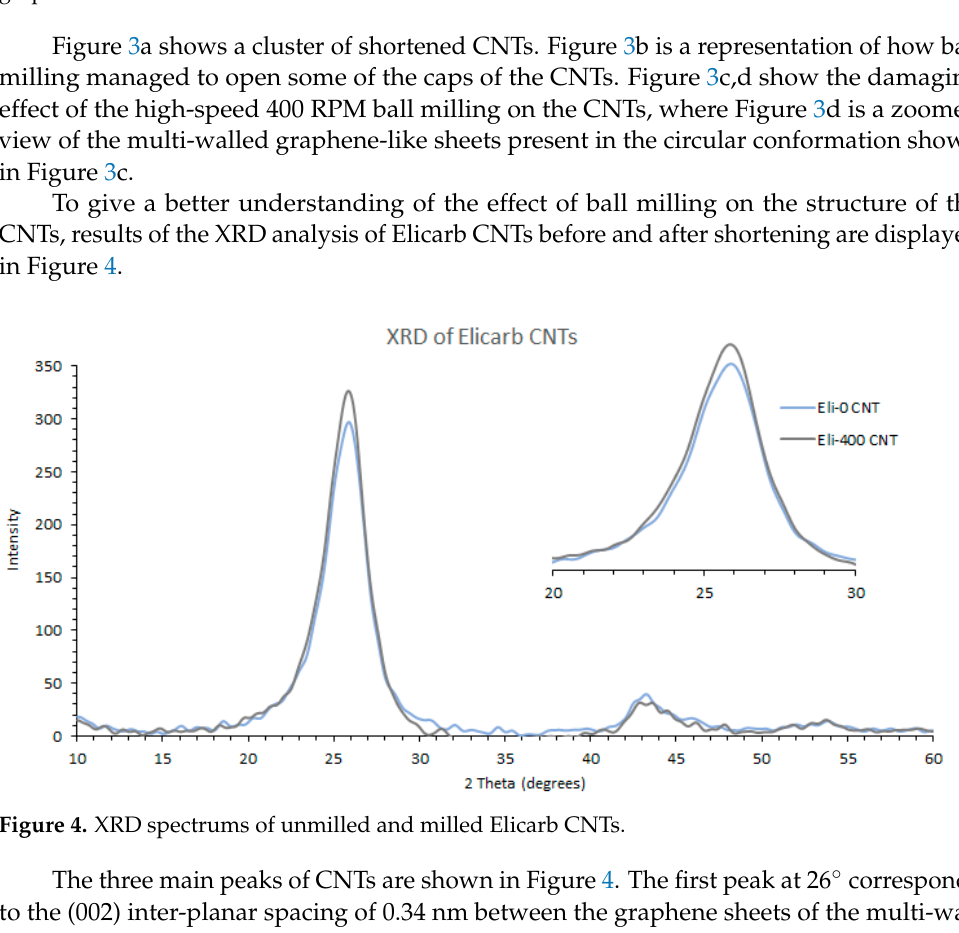
Figure 3. TEM of Eli-400 CNTs: ( a ) CNT agglomerate, ( b ) magnified part of the agglomerate to show the open cap, ( c ) damaged CNTs, and ( d ) magnified part of the damaged CNTs showing the graphene walls